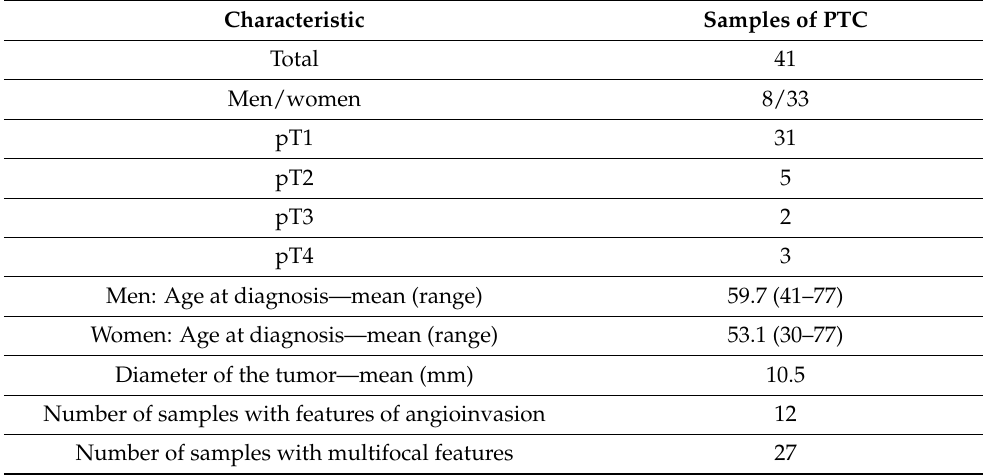
Table 1. Characteristics of the study